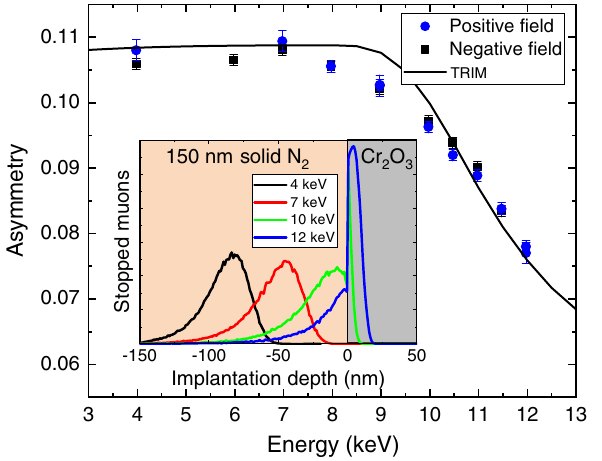
FIG. 7. Measured LE- μ SR asymmetry (blue circles and black squares) for positive and negative applied magnetic fields and TRIM . SP prediction (solid black line) as a function of muon implantation energy for a 150-nm-thick solid nitrogen layer on Cr 2 O 3 . Inset: Muon stopping profiles calculated using TRIM . SP for various muon implantation energies.